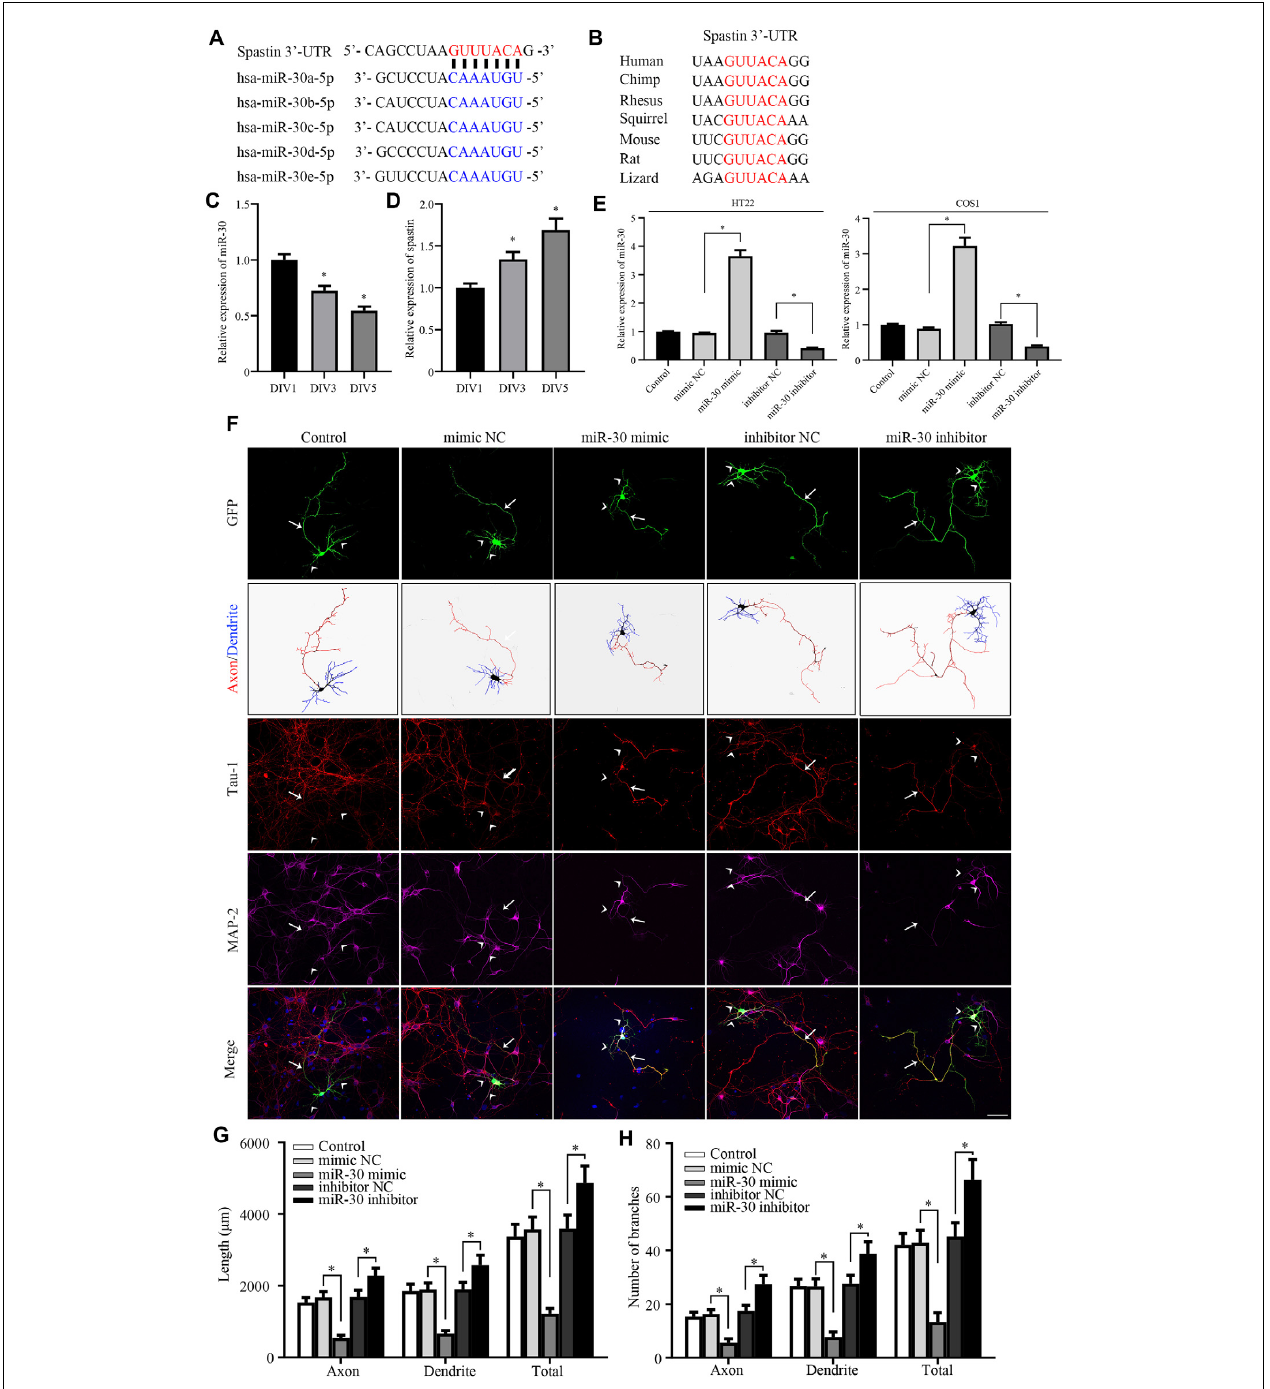
FIGURE 1 | miR-30 inhibits neurite outgrowth in cultured hippocampal neurons. (A) Bioinformatic analysis using the TargetScan tool showing the sequence of the spastin 3 (cid:48) -UTR is targeted by five members of the miR-30 family. (B) Alignment of the miR-30-targeted spastin 3 (cid:48) -UTR sequences from different species shows high homology. The relative expression levels of miR-30 (C) , and spastin (D) obtained using qPCR in DIV1, DIV3, and DIV5 stages of hippocampal neuron development ( n = 3). (E) HT22 and COS1 cells were cultured and transfected with miR-30 mimics and inhibitor fragments. qPCR was performed to determine the level of miR-30 expression. The miR-30 mimic or inhibitor fragments together with the GFP plasmid were then transfected into DIV3 hippocampal neurons for 48 h and subjected to immunofluorescence with GFP, MAP2 (for dendrite), and Tau-1 (for axon) antibodies to determine neuronal morphology. Nuclei were stained with DAPI. The tailed arrow indicates the axon, while arrows with no tail indicate dendrites. Panel (F) shows representative images. The length (G) and the number of branches (H) of neurites were also measured ( n = 4; neuron number > 30/group of each experimental repeat). ∗ P < 0.05. Scale bar, 50 µ m.